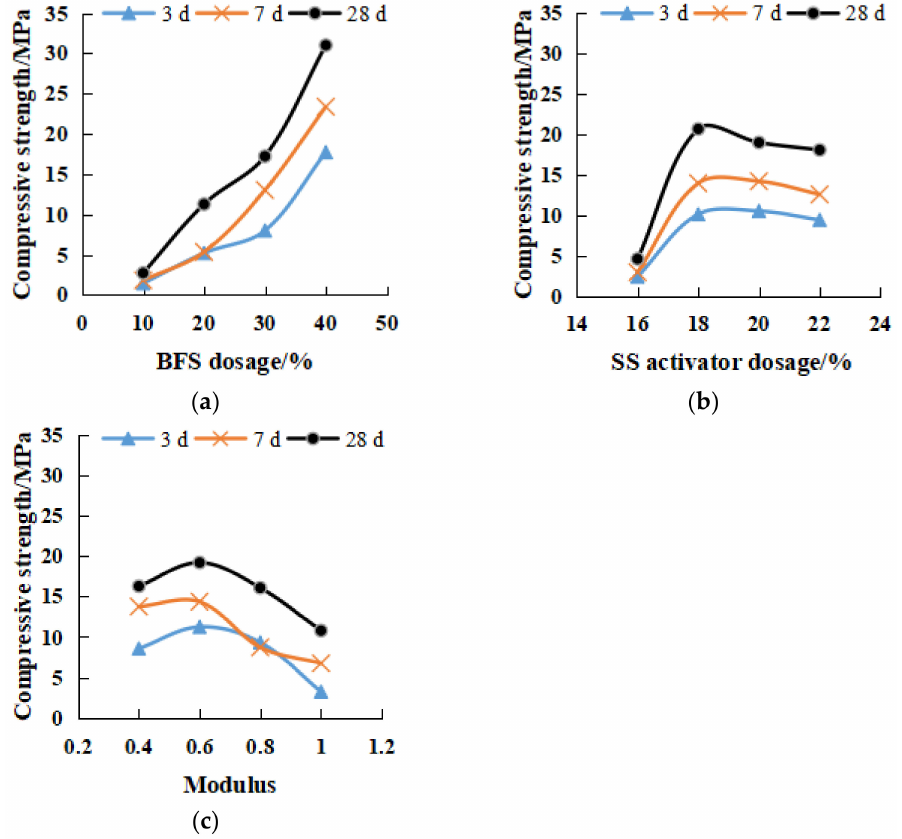
Figure 6. Influence of various factors on compressive strength. ( a ) different dosage of BFS. ( b ) different dosage of SS activator. ( c ) different